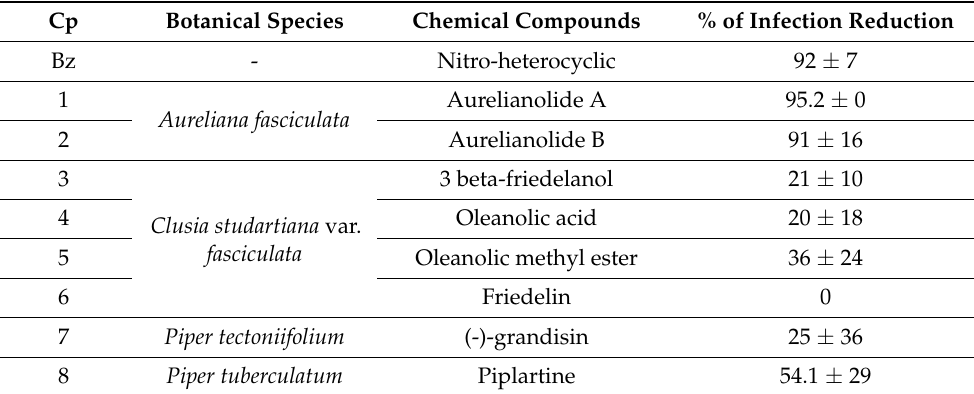
Table 3. Data (species and metabolites) and anti- T. cruzi (Tulahuen strain) activity at 10 µ M after 96 h